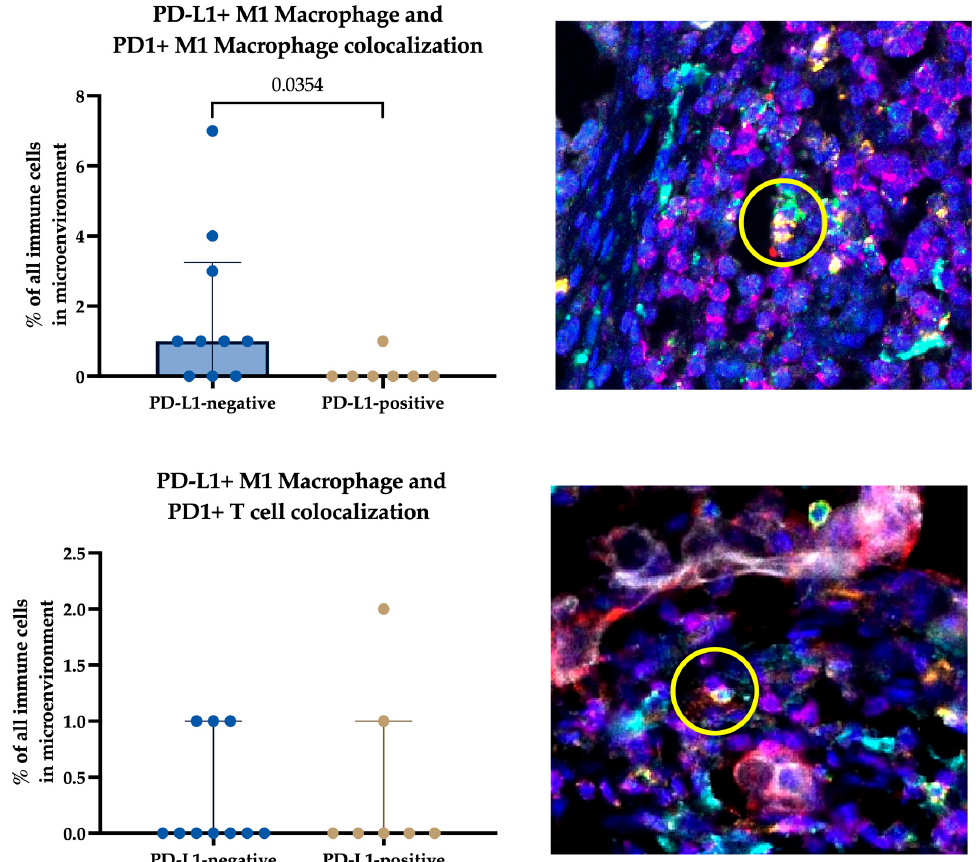
Figure 5. Variants of PD-L1-expressing cells and PD1-expressing cells colocalize in PD-L1-negative and PD-L1-positive tumors. Data are presented as percentages of PD-L1- PD1 cell pairs from all immune cells in the microenvironment. Yellow circle indicates the PD1-PD-L1 interaction in the tumor microenvironment. Multiplex TSA-associated IHC. Magnification 200×.